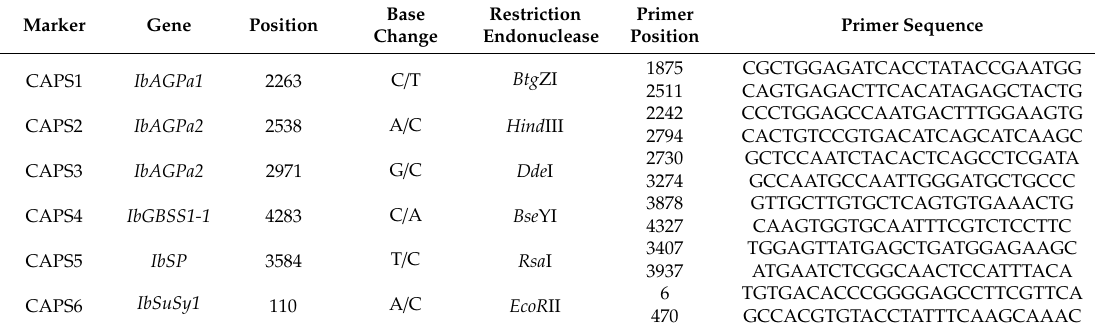
Table 2. Cleaved amplified polymorphic sequence (CAPS) markers developed based on nsSNPs and tested in sweet potato